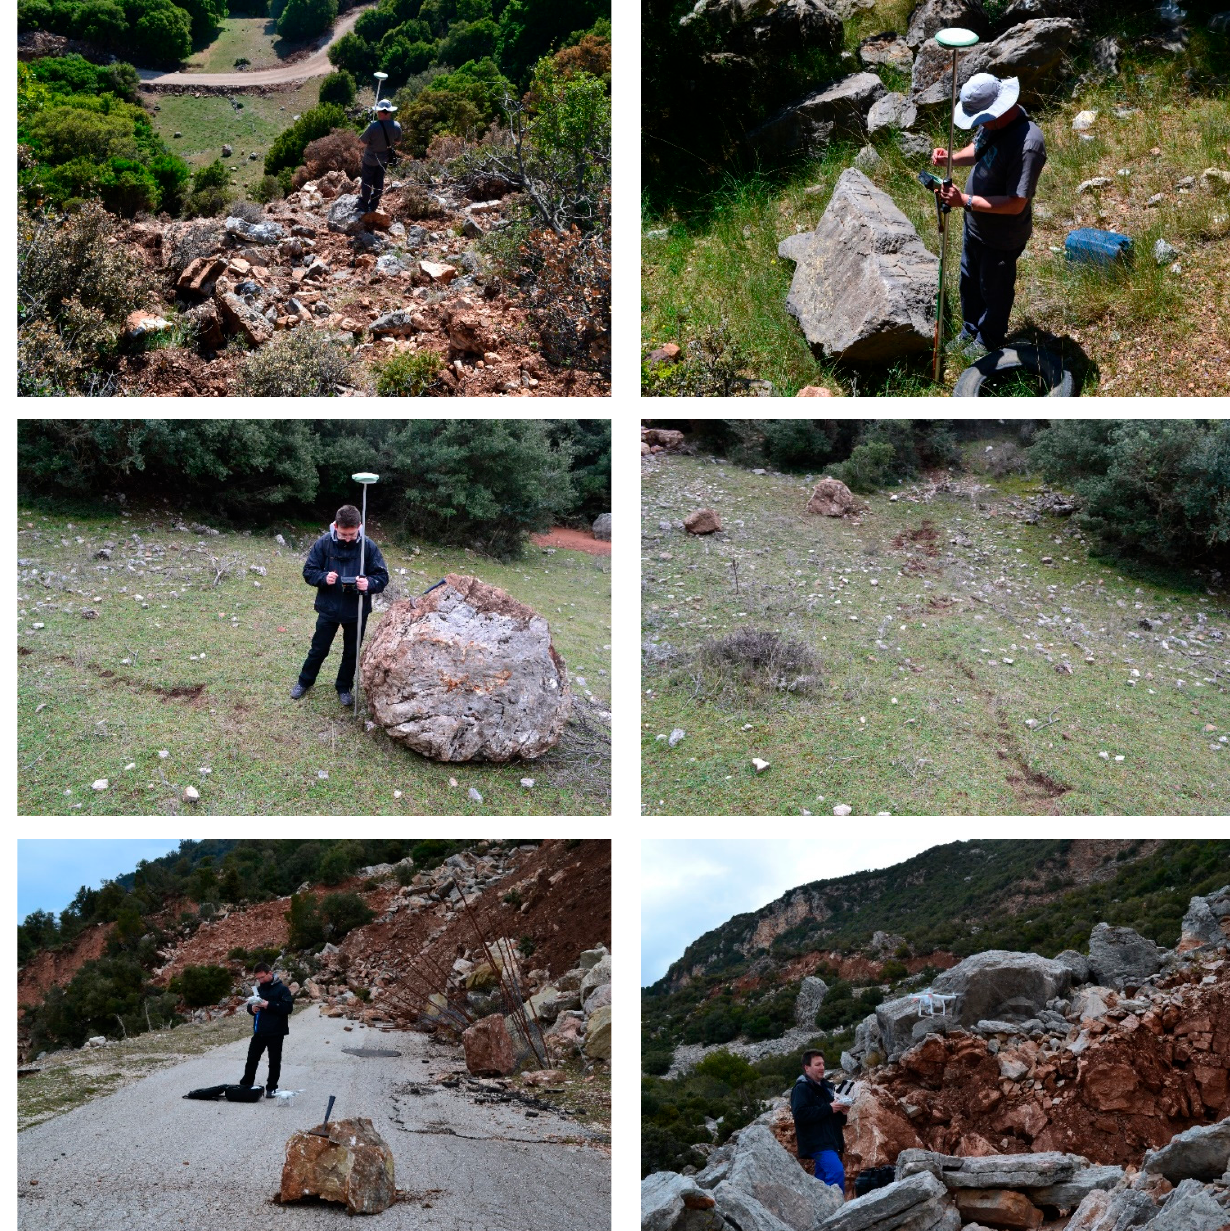
Figure 2. Pictures taken from Moira region after rockfall event.